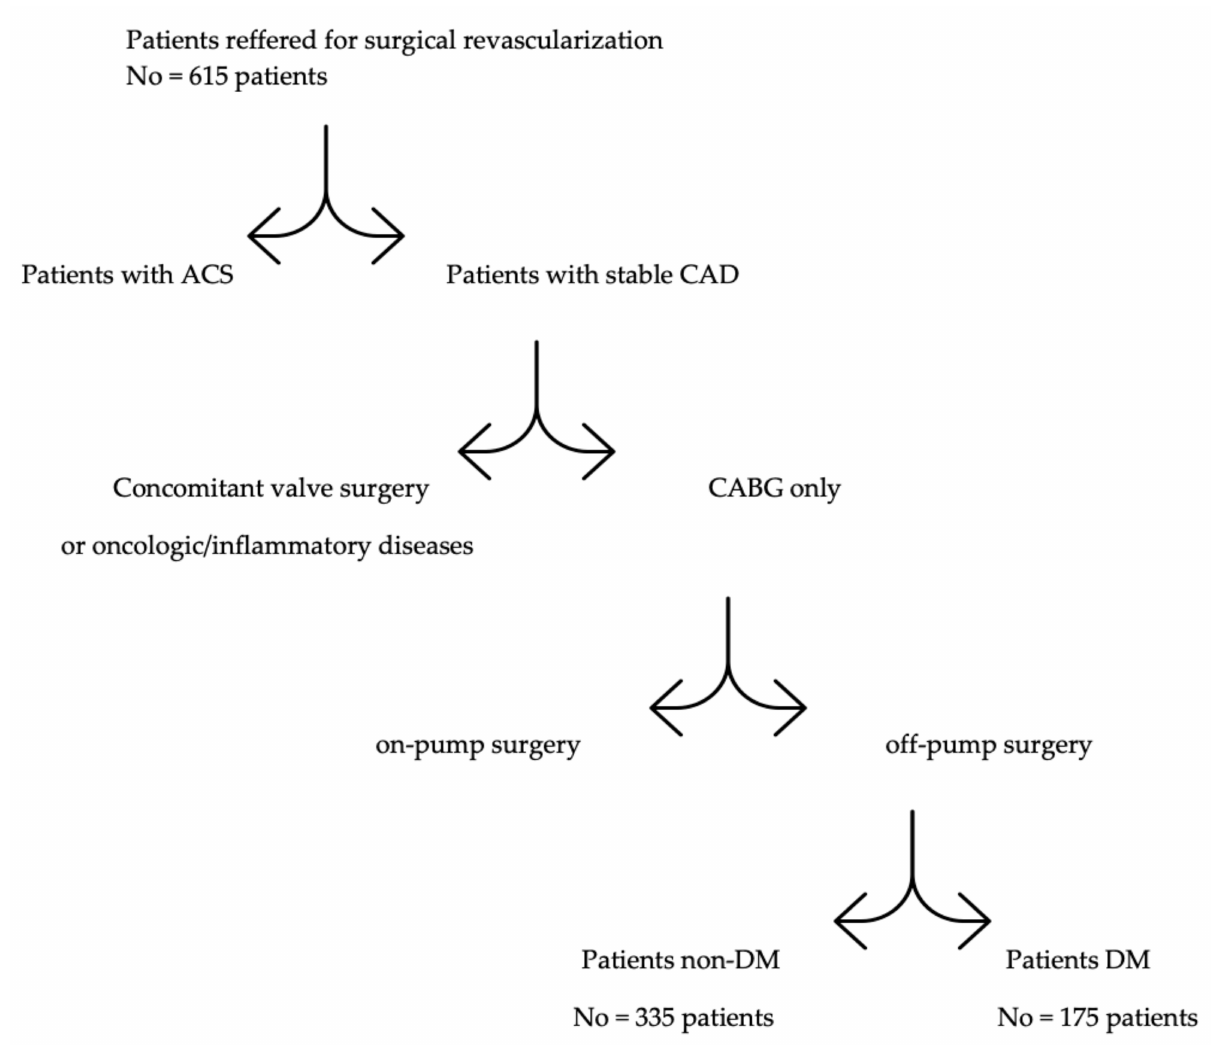
Figure 1. Inclusion criteria for retrospective